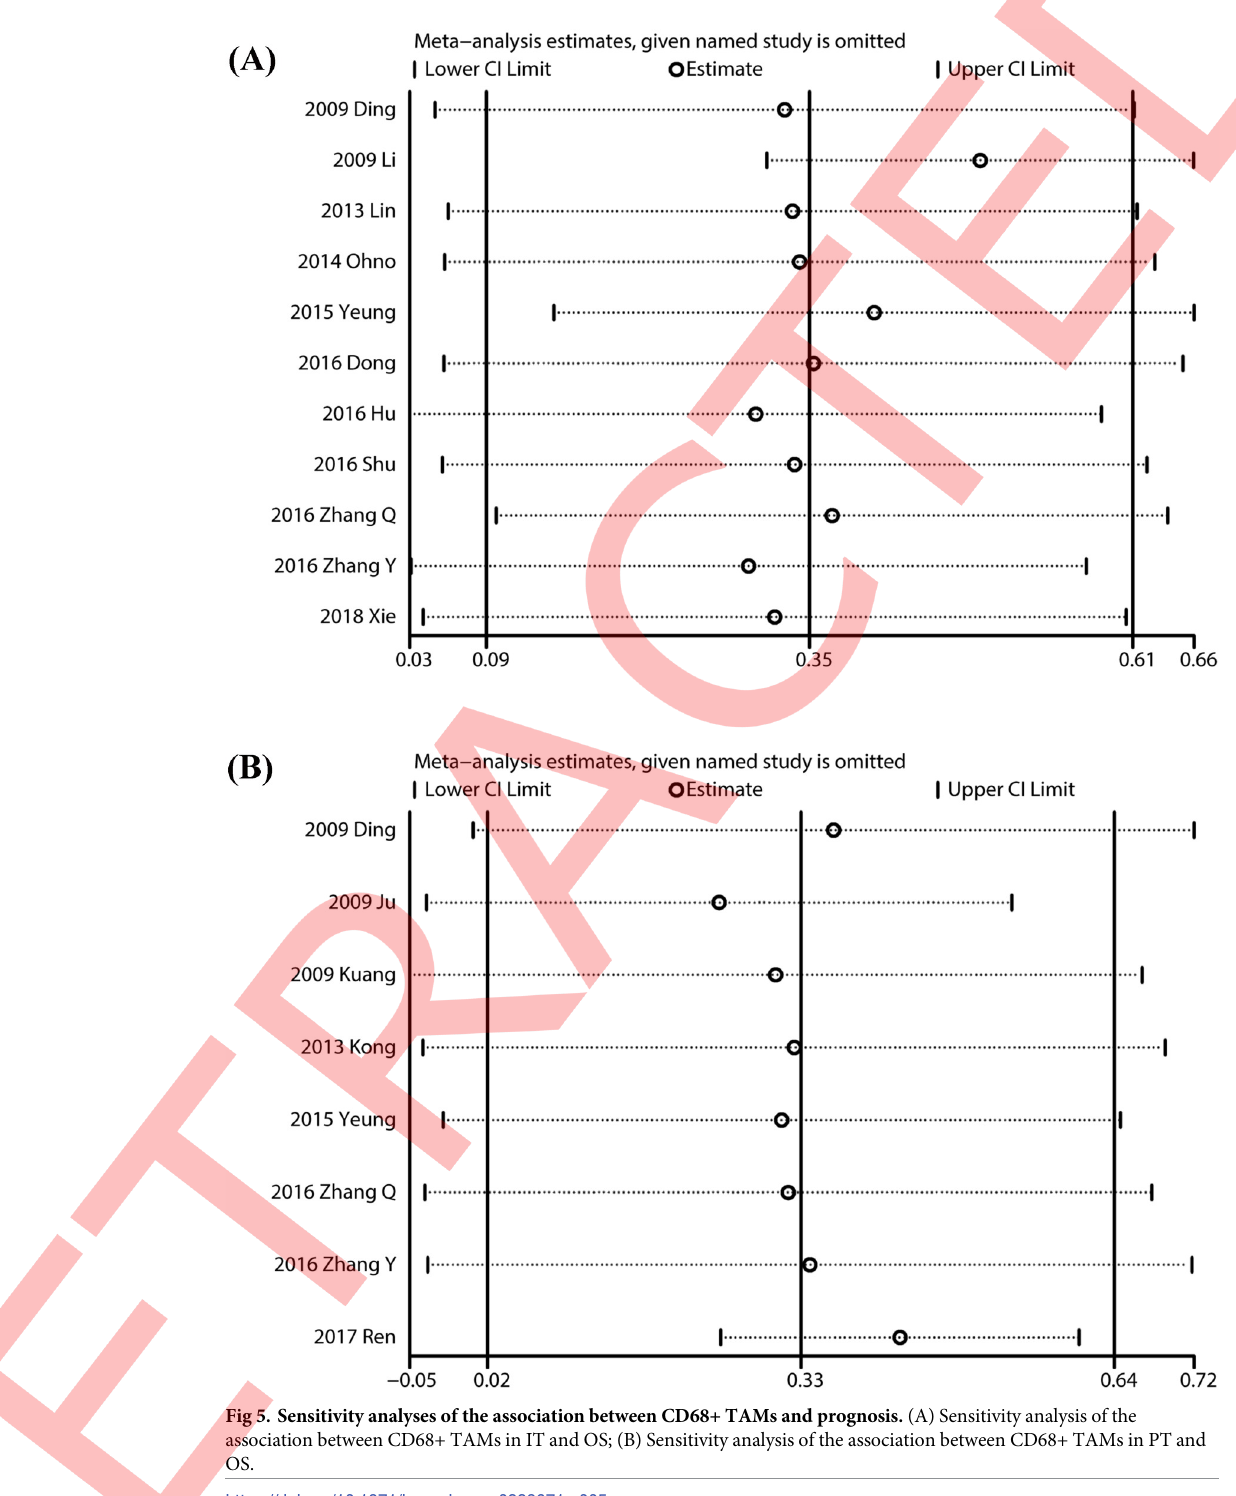
Fig 5. Sensitivity analyses of the association between CD68+ TAMs and prognosis. (A) Sensitivity analysis of the association between CD68+ TAMs in IT and OS; (B) Sensitivity analysis of the association between CD68+ TAMs in PT and